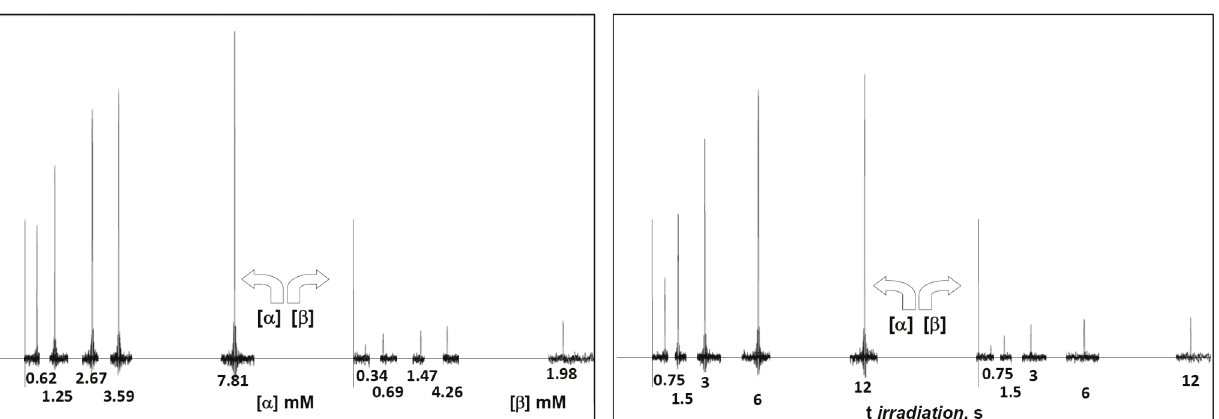
Figure 1. 1 H (cid:2) 1 H STD and 1 H (cid:2) 1 H STDre 19 F STD decoupled spectra of a 2FDM/ConA sample, in 99% D 2 O at 280 K and 0.75 s irradiation. At the left: 1 H (cid:2) 1 H STD spectrum (bottom) and corresponding off -resonance spectrum (at the top). Several proton signals, H 1 and H 2 of (cid:5)-2FDM and H 2 of (cid:3)-2FDM, are positioned under or very close to the HDO signal at this temperature and its STD information is lost; at the right: 1 H (cid:2) 1 H STDre 19 F (bottom) and the reference 19 F off -resonance spectrum (at the top). Ligand (2FDM) and lectin (ConA) were present at 12.1 mM and 90 μM concentrations, respectively.